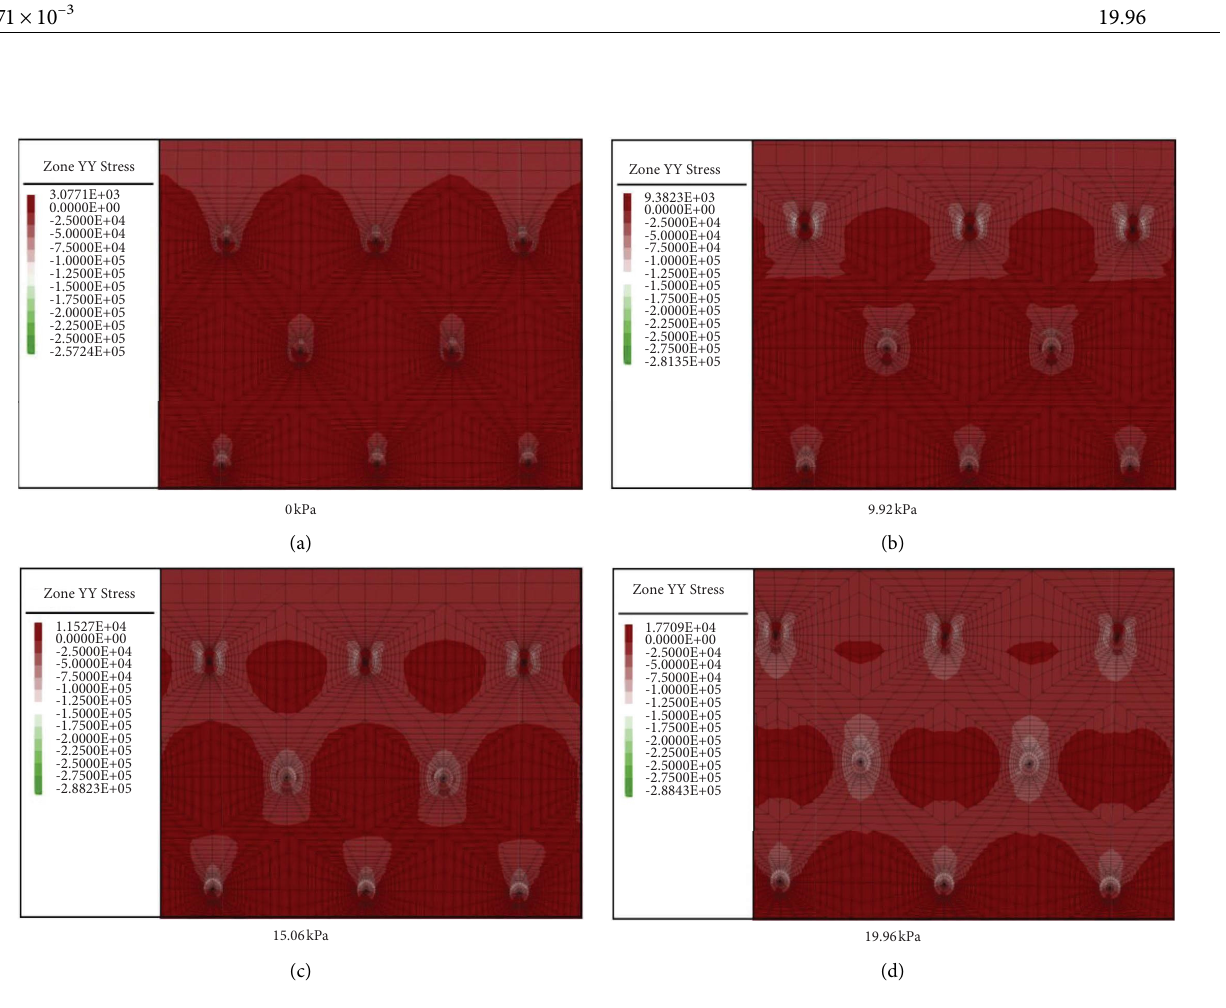
Figure 1: Positive stress in y -direction under diferent swelling forces. (a) 0kPa, (b) 9.92kPa, (c) 15.06kPa, and (d) 19.96kPa.